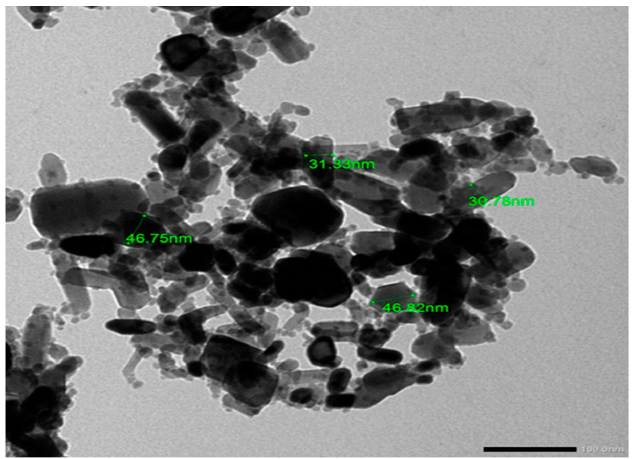
Figure 1. TEM image showing the shape and diameter of the zinc oxide nanoparticles (ZnONPs) being less than 50 nm (scale bar = 100 nm). being less than 50 nm (scale bar = 100